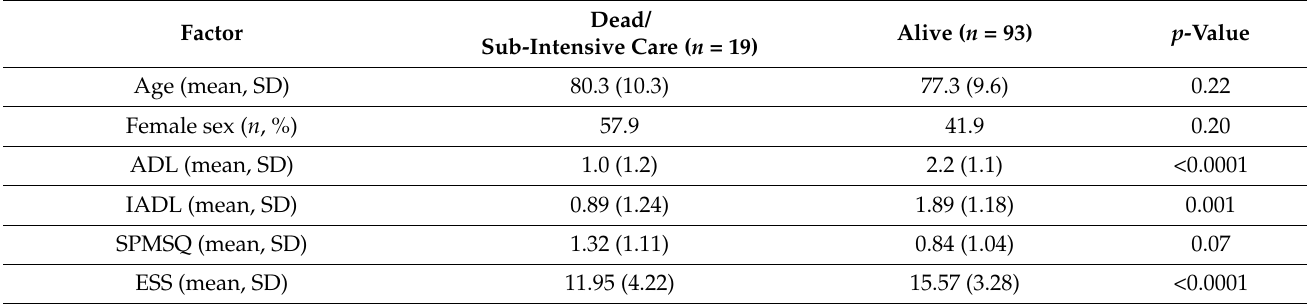
Table 1. Descriptive characteristics at the baseline by survival